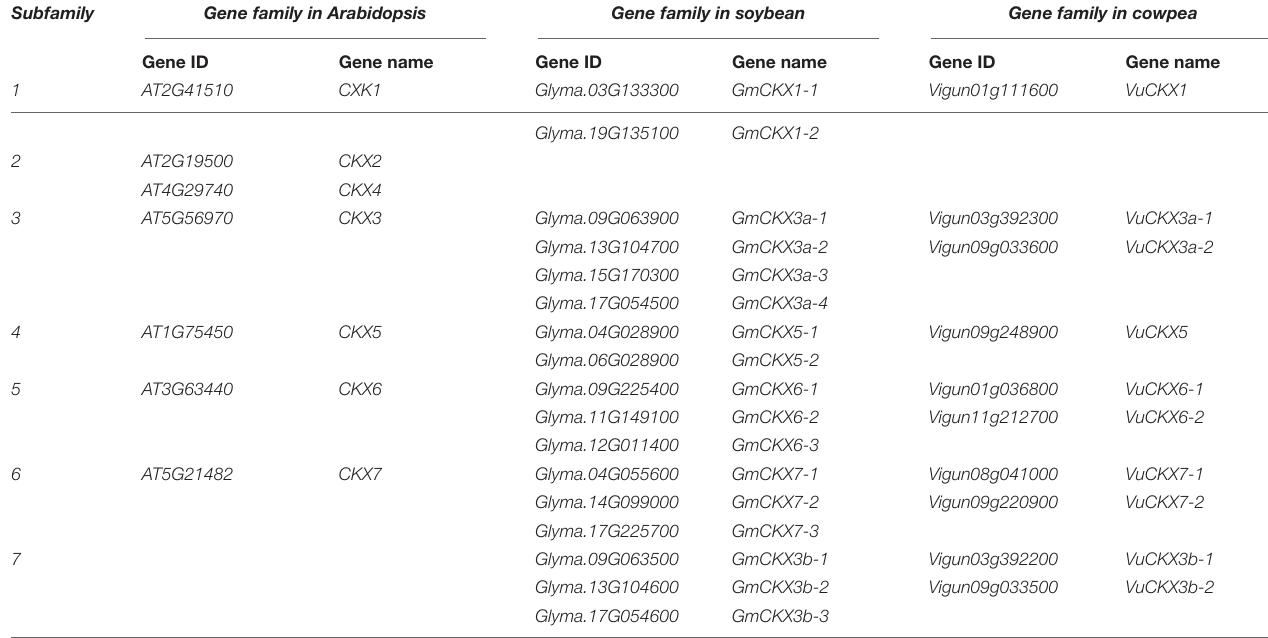
TABLE 2 | Homologous genes of CKX gene family in soybean, cowpea, and Arabidopsis thaliana . Subfamily Gene family in Arabidopsis Gene family in soybean Gene family in